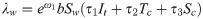
Compartmental diagram of the constructed model involving the interaction of cattle, small ruminants, wildlife, tsetse flies, tabanids and Stomoxys with Trypanosoma species.NB: we denote λk = bSk(φk1It + φk2
Tc + φk3Sc), λt = bφt
St(Ik + Iw + Ir), λs = bα2
Sn(Ik + Iw + Ir), λT = bα1
Tn(Ik + Iw + Ir), λw=eω1bSw(τ1It+τ2Tc+τ3Sc), λr=eω2bSr(ζ1It+ζ2Tc+ζ3Sc), τ = (τ1 + τ2 + τ3), ζ = (ζ1 + ζ2 + ζ3) in the model diagram and model analysis.